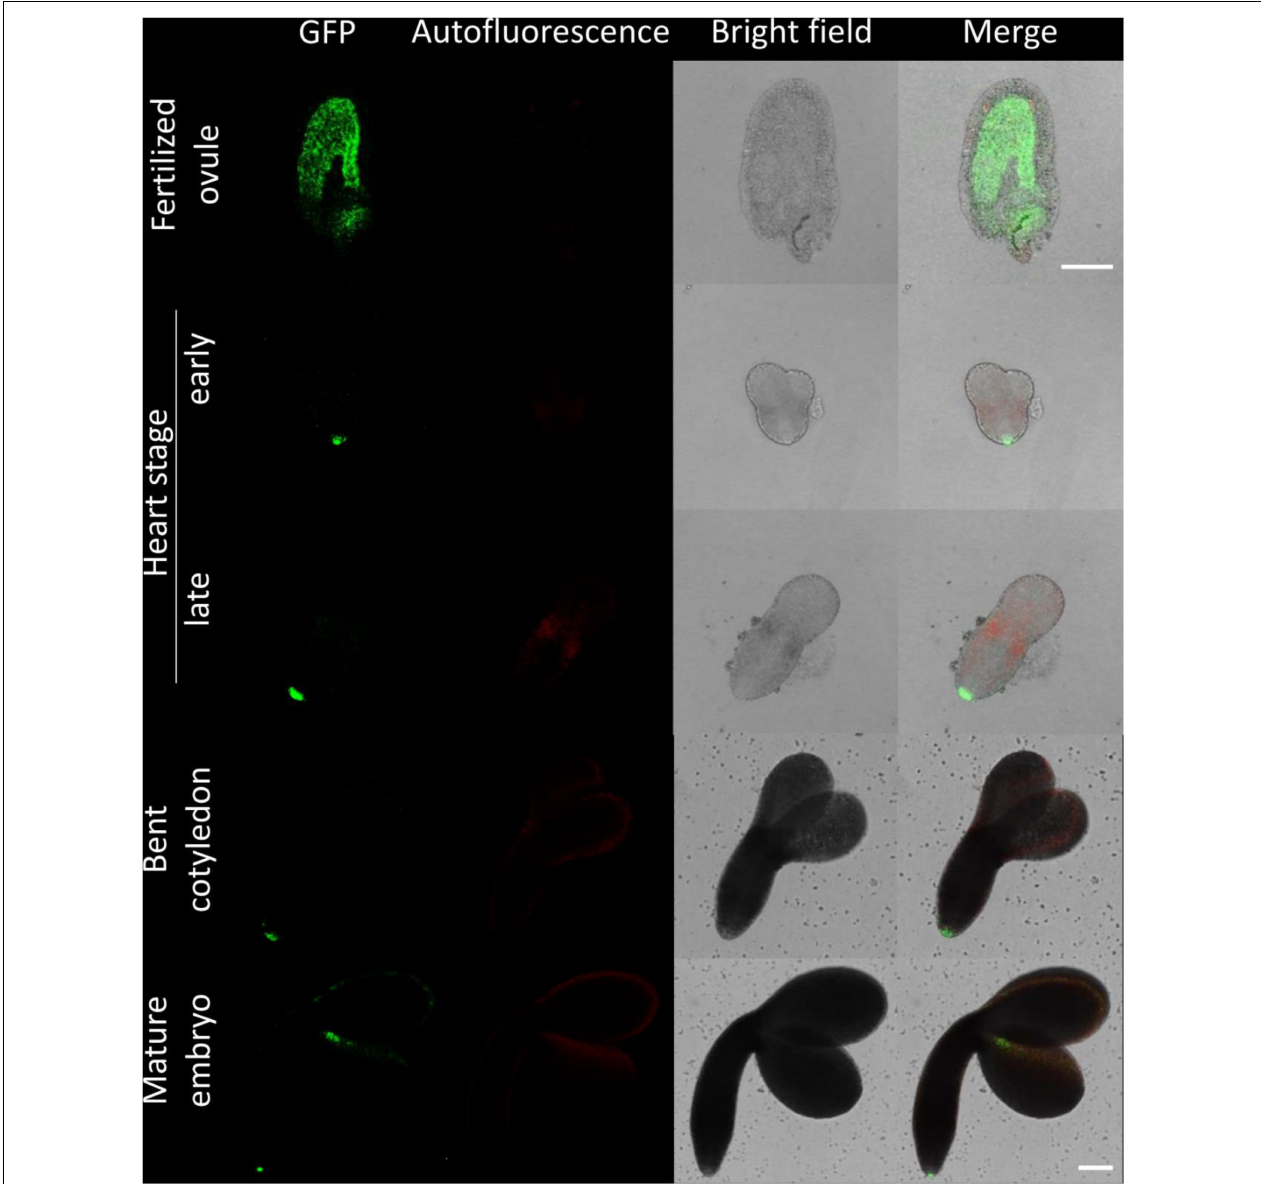
FIGURE 3 | Fluorescence imaging of CTPS2::GFP lines in embryo cells. Siliques of soil-grown plants (lines CTPS2::GFP #10 and #15) were opened 2 days after fertilization (DAF) and between 6 and 8 DAF, and seeds were harvested. Ovules and embryos were isolated from seeds for confocal laser scanning microscopy. Typical images are shown. Scale bar = 100 µ